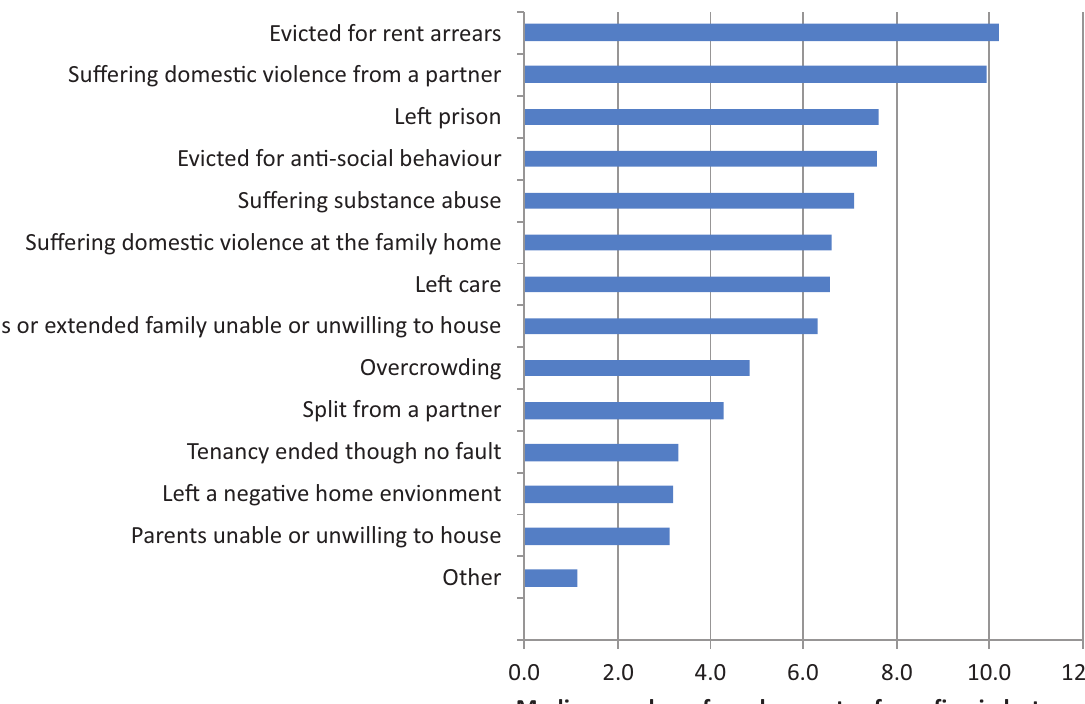
Figure 2. Median length of time spent sofa surfing by reason, among people aged 16–24 identified as sofa surfing in the year to September 2014. Source: Clarke et al. (2015). Table 5. Estimated number of people aged 16–24 ‘sofa surfing’ on any one night in the year to September 2014. Number of young people answering survey 2,011 Number who have sofa surfed during the last year [From survey] 409 Total number of sofa surfing nights in last year [Sum of all lengths of time sofa surfing by all respondents] 20,977 Average number sofa surfing on any one night during last year [Total number of sofa surfing nights (20,977), divided by total number of nights in the year (365)] 57 Proportion of young people sofa surfing on any one night [Average number sofa surfing on any one night (57) divided by number of young people answering survey (2,011)]